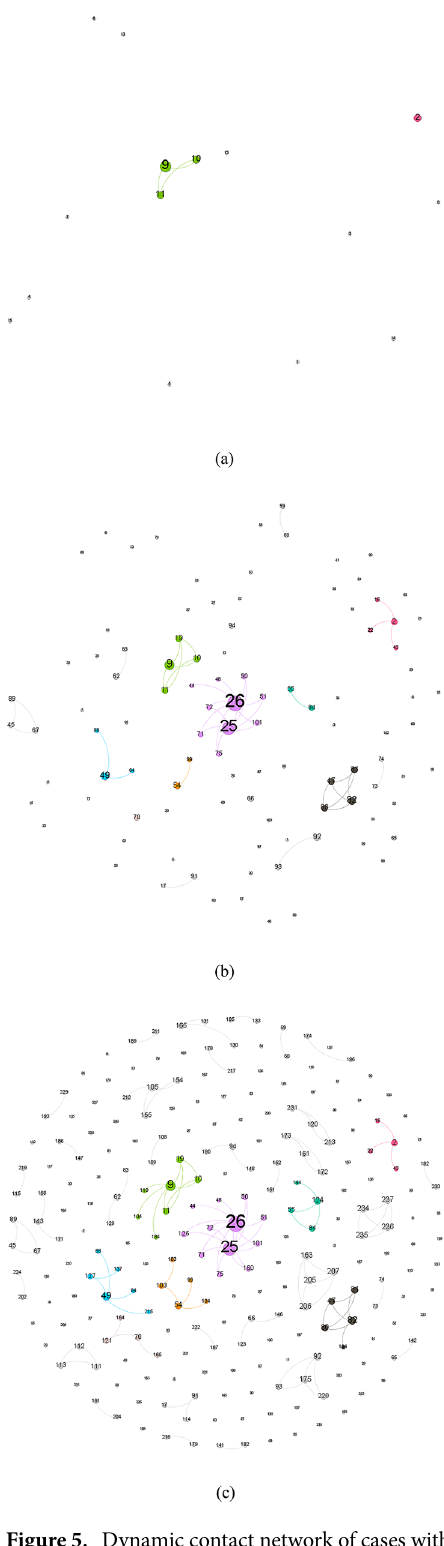
Figure 5. Dynamic contact network of cases with COVID-19 in Shaanxi Province. In the network, nodes represent cases, edges represent transmission routes between cases. The larger the node size, the greater the number of the case connected with. The number on each node is the case number. The larger the number, the later the case is diagnosed. ( a ) Contact Network on January 25, 2020. ( b ) Contact Network on February 1, 2020. ( c ) Contact Network on February 16,